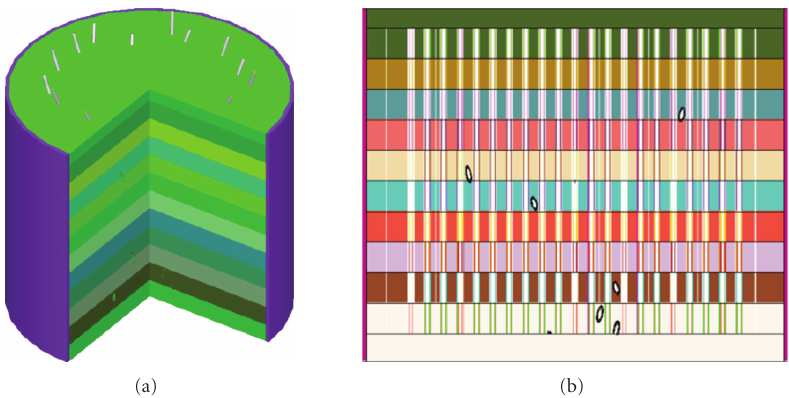
Figure 4: Atucha-2 KENO-VI and MCNP5 models, ten levels of axial detail.